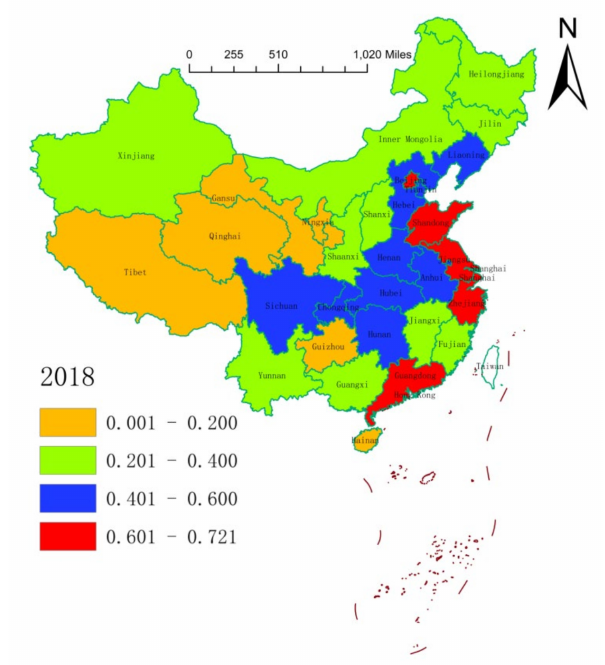
Figure 3. Spatial distribution of health resource agglomeration capacities in China in